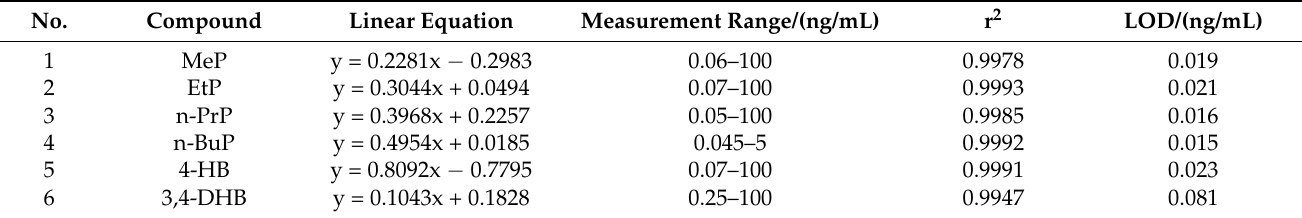
Table 2. Linear equations, measurement ranges, correlation coefficients, limits of detection of parabens and their metabolite